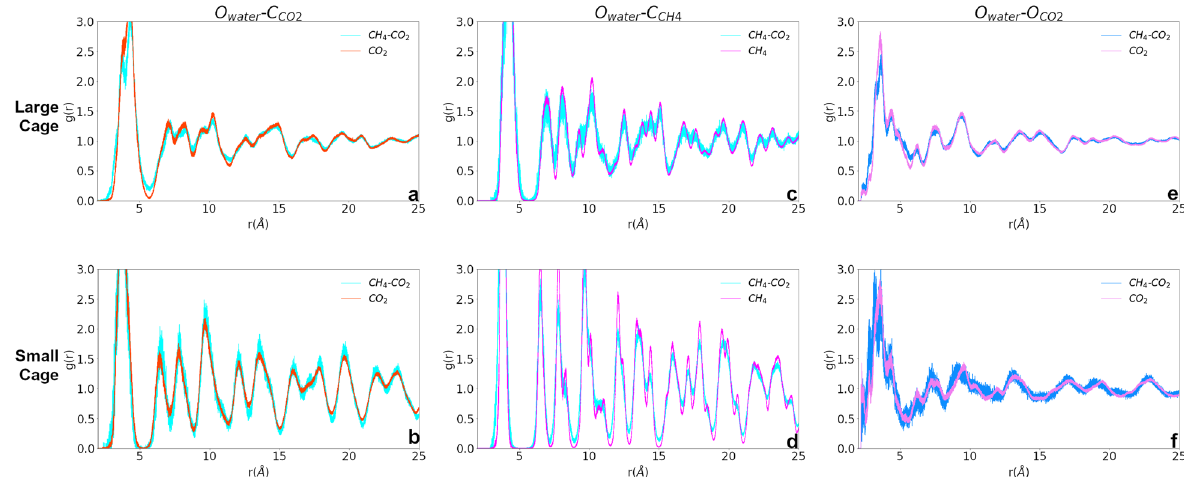
Fig. 3 Host – guest RDFs. RDFs to investigate guest – host interactions in three hydrate compositions. O water – C CO2 RDFs for the large cage ( a ) and small cage ( b ) CO 2 centers and O water – C CH4 RDFs for the large cage ( c ) and small cage ( d ) CH 4 centers indicate that CO 2 molecules are not as ordered in their positions as CH 4 . Orientations of the linear CO 2 in O water – O CO2 RDFs in the large cage ( e ) and small cage ( f ) show that the CO 2 in mixed hydrate orients in more positions towards the